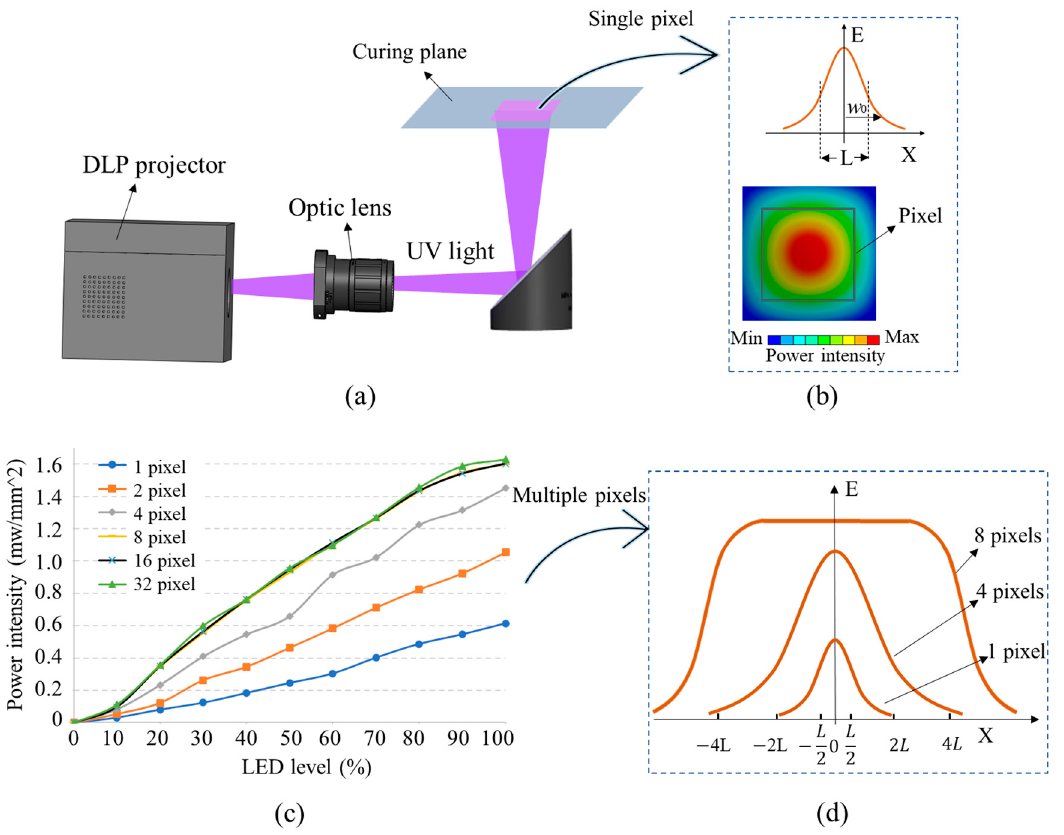
Figure 1. The process analysis. ( a ) The built projection stereolithography 3D printing system, ( b ) the power intensity distribution for single pixel, ( c ) the measurement result of the power intensity and ( d ) the power intensity distribution for multiple pixels.